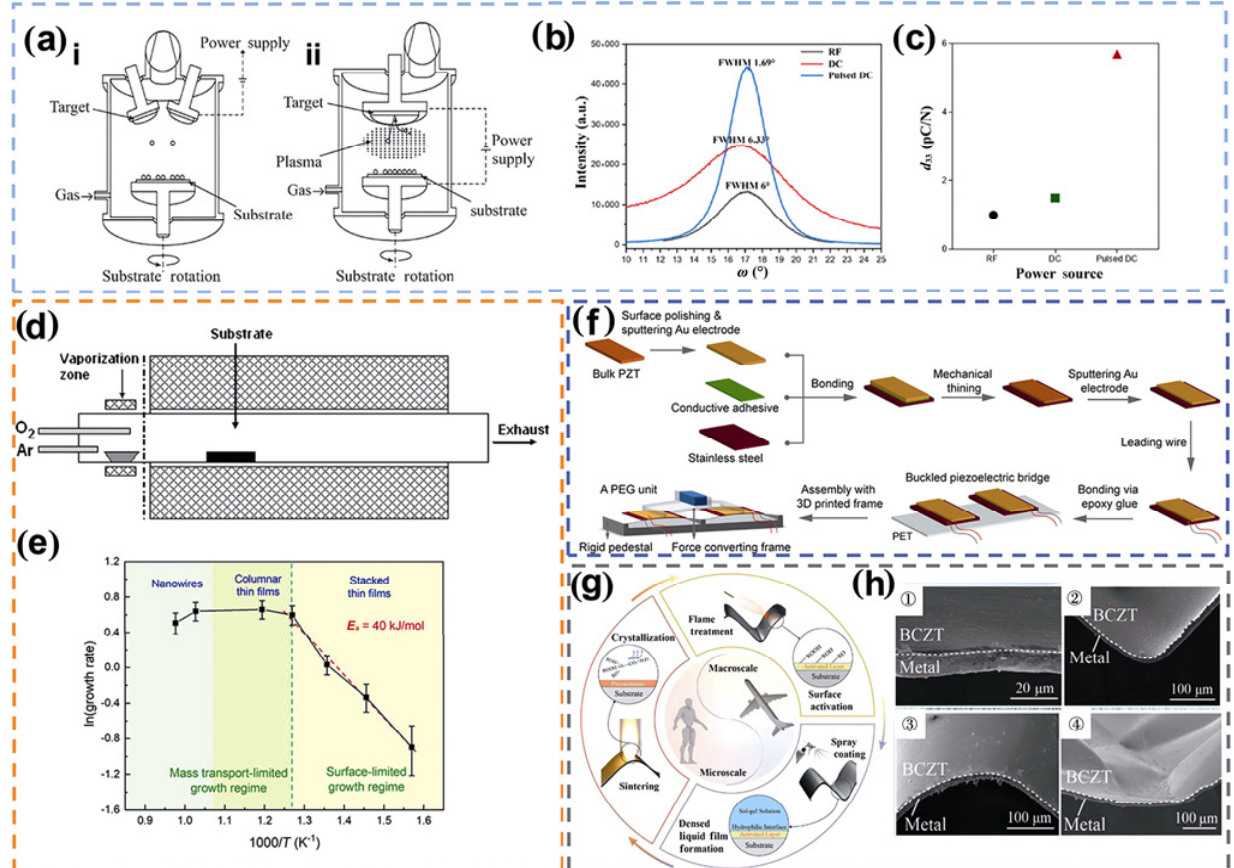
Fig. 6 (a) (i) Schematic of confocal sputtering machine demonstrating angled guns and large target to substrate ratio and d results for DC, RF, and pulsed DC sample. (d) Schematic (ii) direct sputtering arrangement. (b) XRD patterns and (c) 33